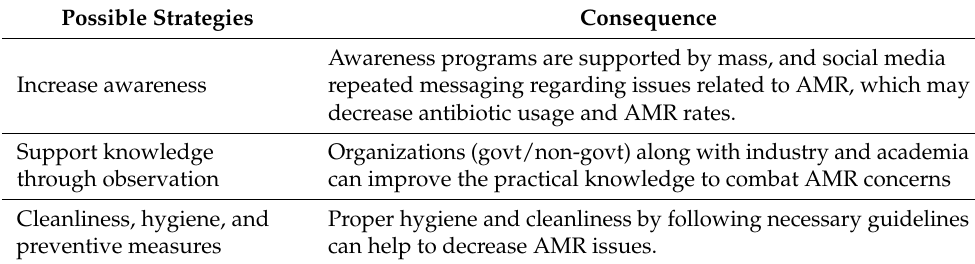
Table 3. Possible strategies to regulate concerns of